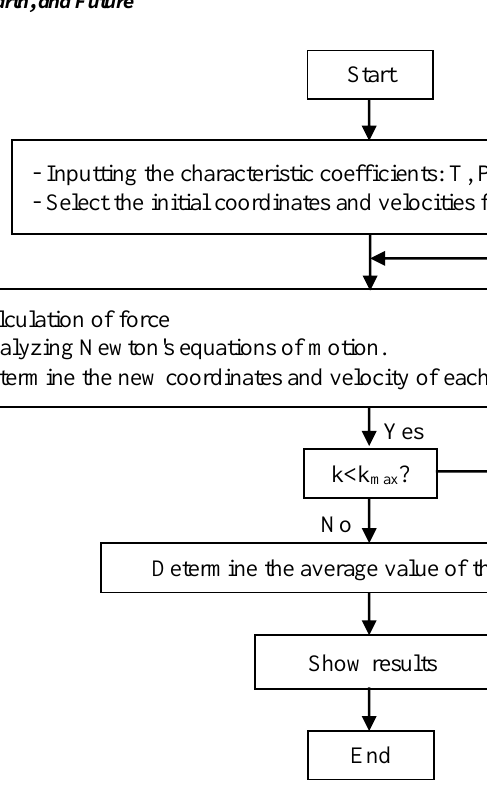
Figure 1. Flowchart of molecular dynamics simulation method Table 1. The structural characteristics of AS2 glass: r X-Y - the position and height of the first peak of RDFs G X-Y (r), CN X-Y - the average coordination number; θ - position of the highest peak of